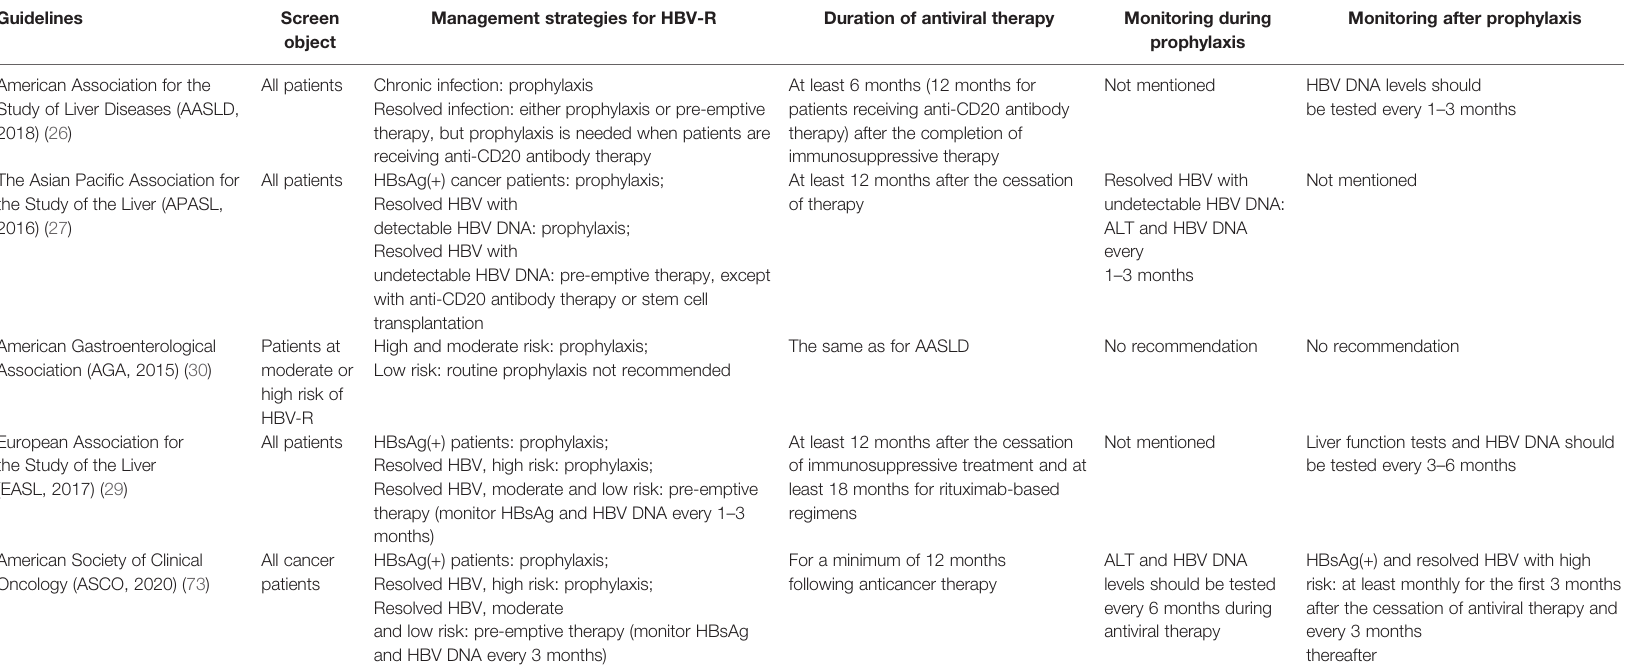
TABLE 3 | Guidelines for the screening, management, and monitoring of HBV-R during immunosuppressive